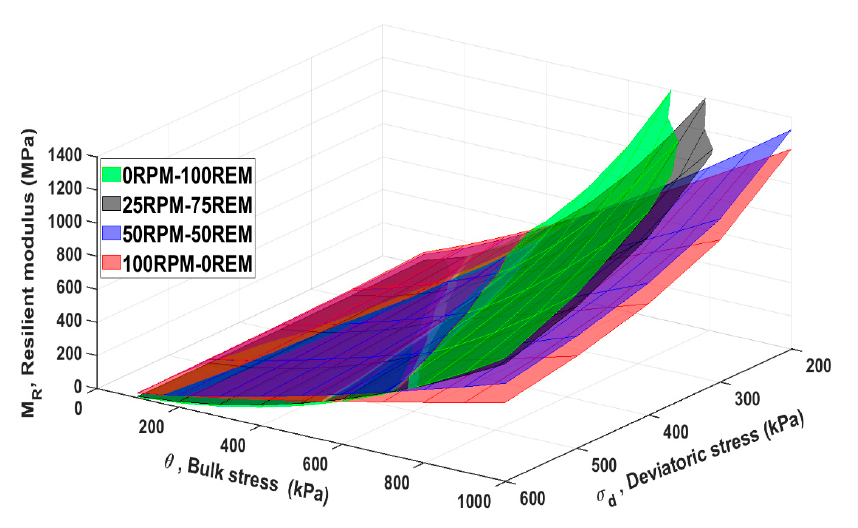
Materials 2021 , 14 , x FOR PEER REVIEW Figure 6. Resilient modulus of pure REM and RPM and blended mixtures by Uzan’s model. Table 2. Regression parameters of Hicks and Monismith’s and Uzan’s models.